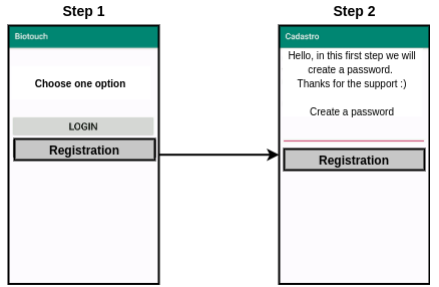
Figure 2. Biotouch app screens for the registration flow.